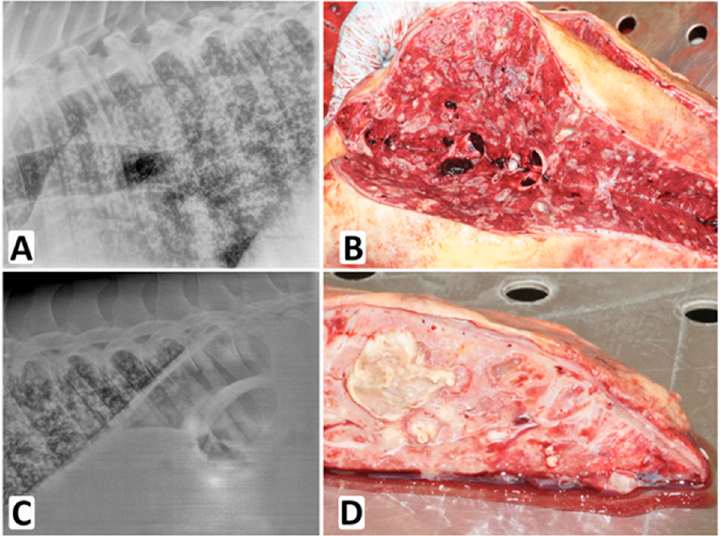
Figure 2. IPA in the equine lungs. Interstitial lung pattern and increased opacity of bronchial walls were recorded by X-ray imaging ( A , C ). Macroscopic Aspergillus lesions were found in the lungs during autopsy ( B , D ).